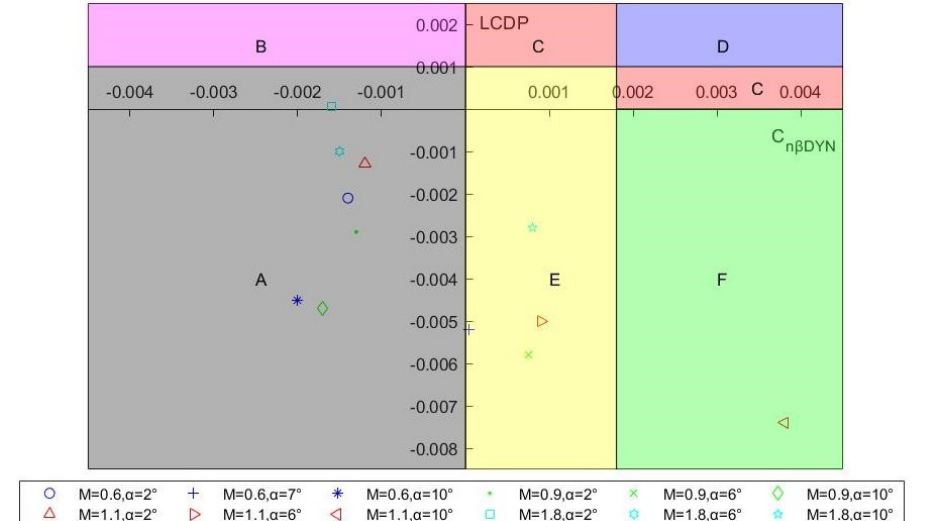
Figure 5. The diagram of Weissman criterion. Area A is the no-deviation area. Area B is the slight deviation area. Area C is a moderate deviation area. Area D is strong deviation divergence area. Area E is the moderate yaw divergence area. Area F is the strong divergence